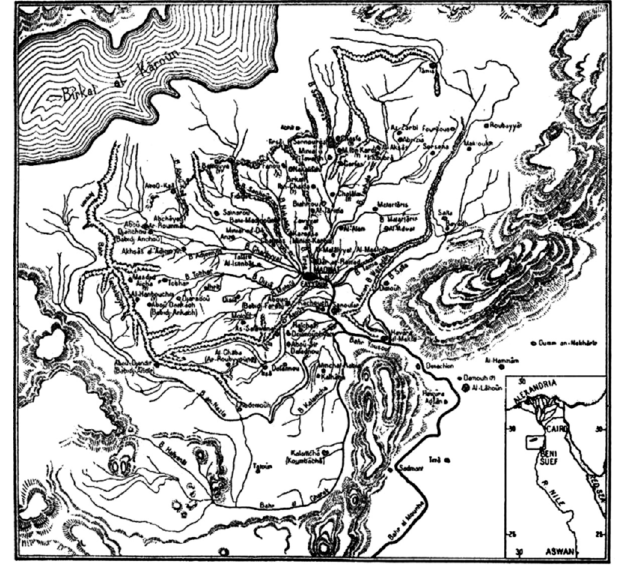
Figure 19. A map of El-Fayyum in Ottoman times (modified from [139]).